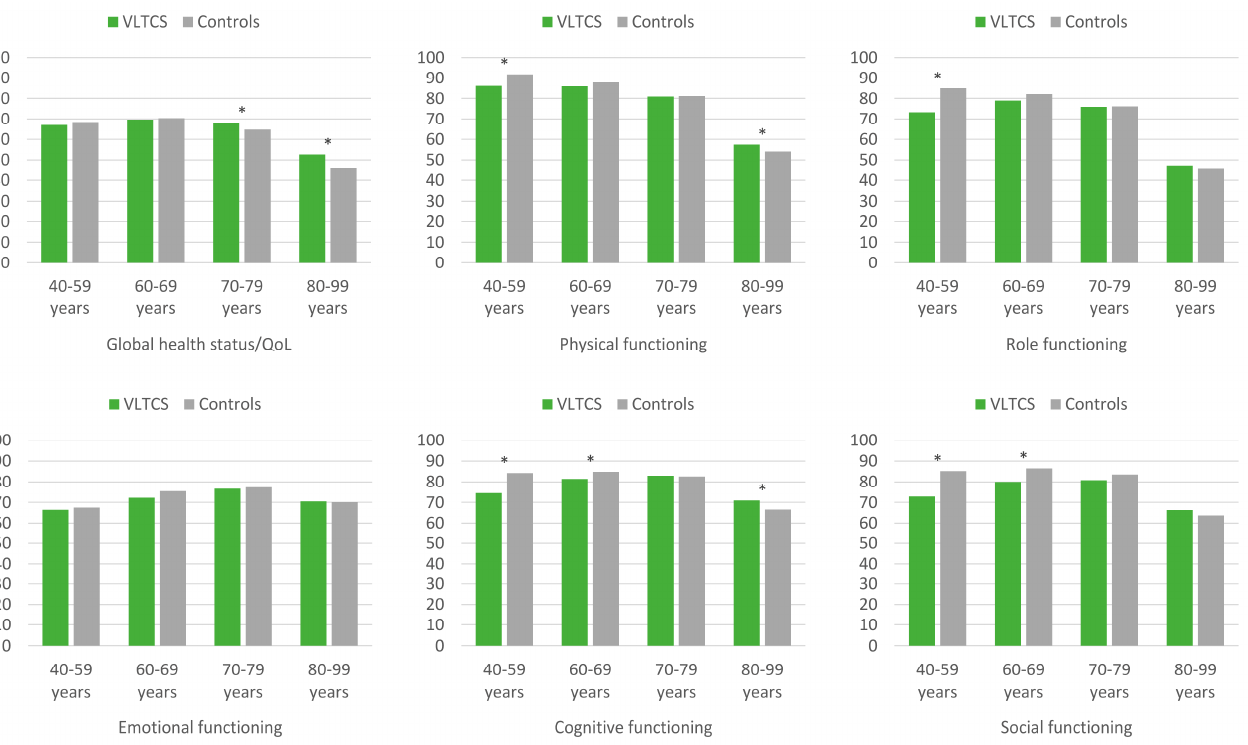
Figure 2. EORTC QLQ-C30 global health status/QoL and functioning scores of very long-term cancer survivors and population controls, stratified by age and adjusted for age, sex, and education. VLTCS, very long-term cancer survivors (recruited via population-based cancer registries). Asterisks (*) mark statistically significant subgroup differences ( p < 0.05). All results are based on 25 imputations of missing values.